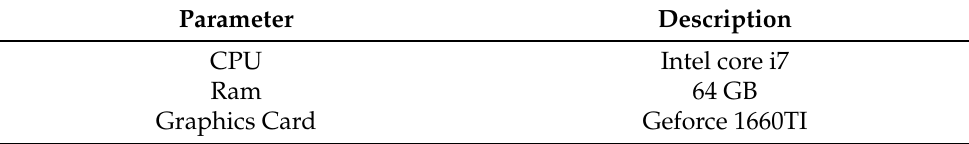
Table 5. Description of